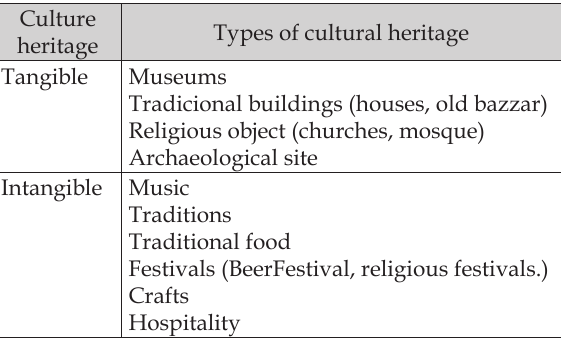
Table. 1. Elements of the cultural heritage in Korça city and the surrounding area (Menkshi